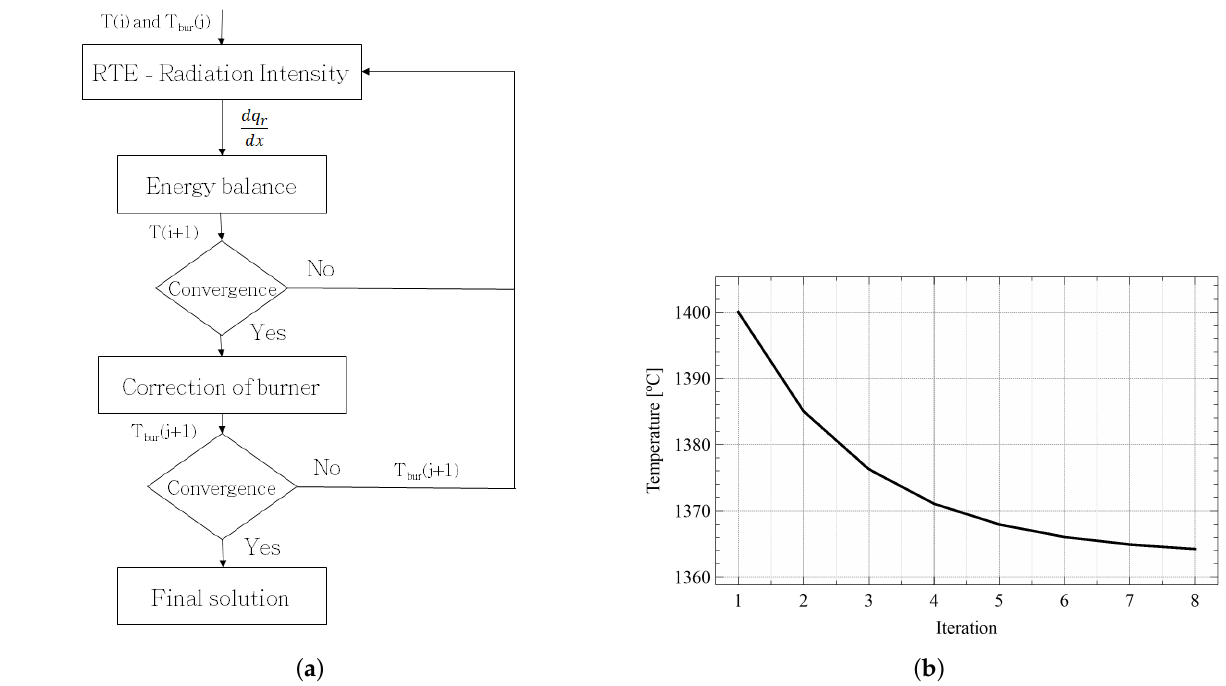
Figure 4. Iterative procedure for computing burners surface temperature: ( a ) flow chart; and ( b ) example of